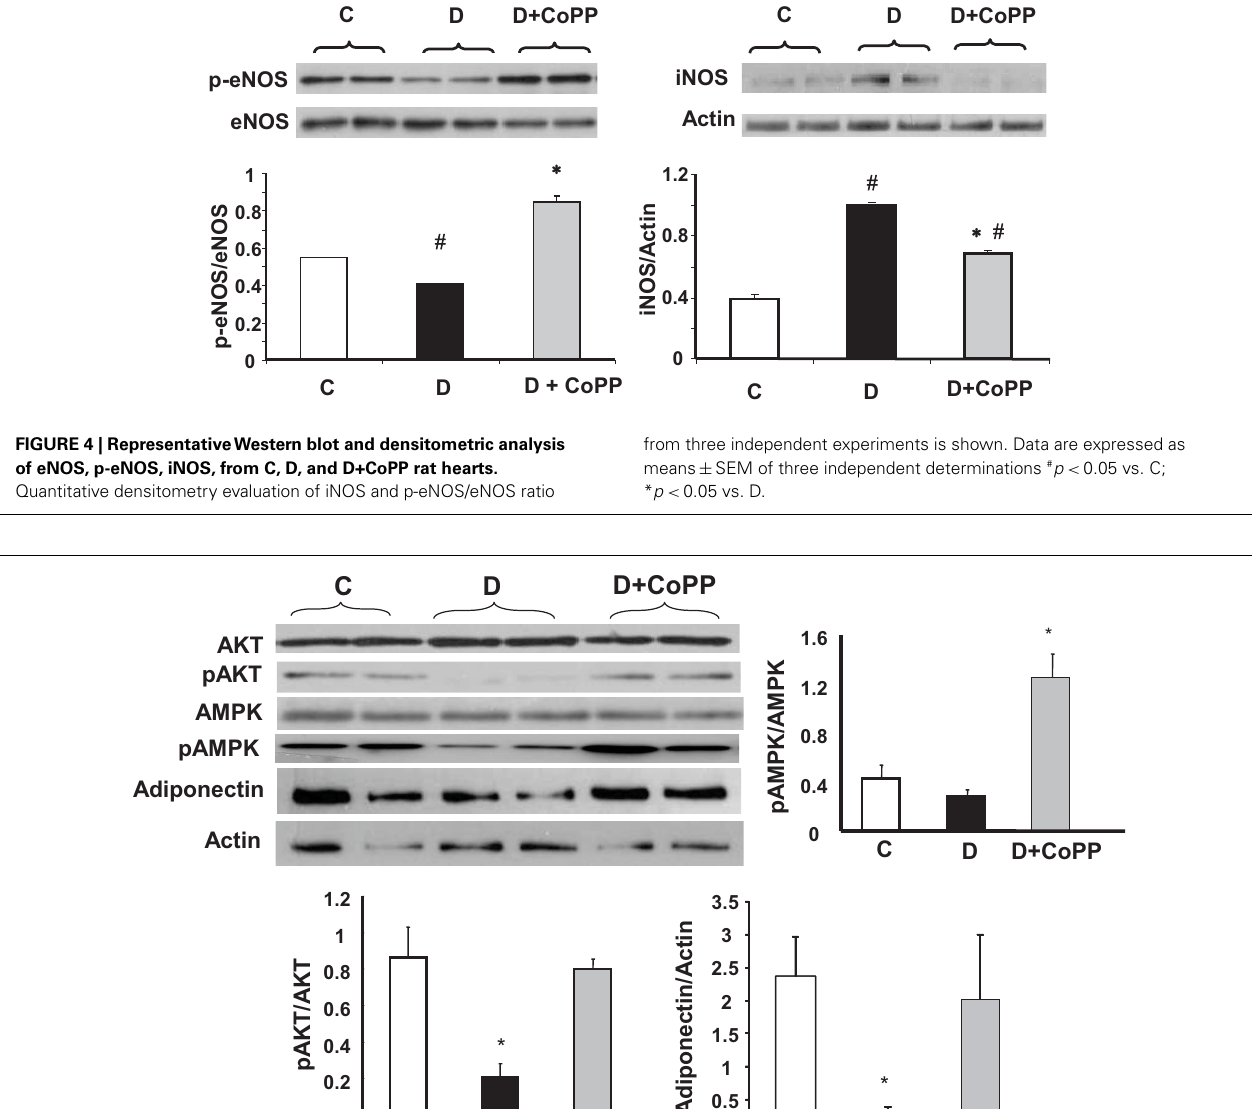
independent determinations of pAkt/Akt and pAMPK/AMPK ratios as well as of adiponectin/actin ratio. * p < 0.05 vs. other groups; # p < 0.01 vs.